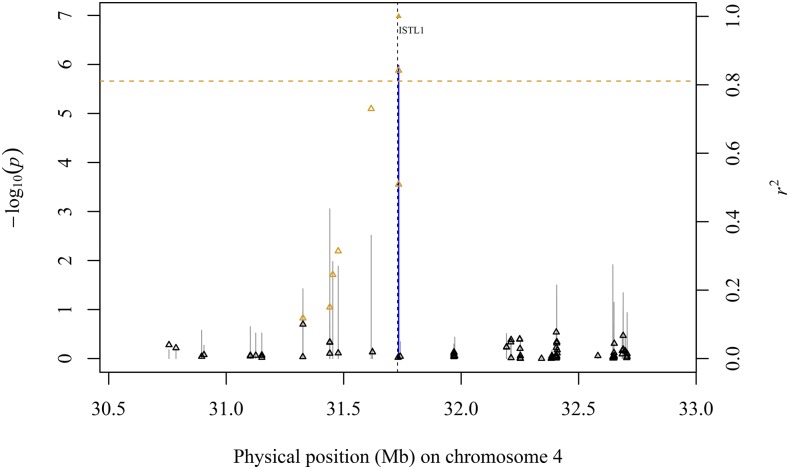
Association of SNP markers with adult maize leaf cuticular conductance (gc) across a genomic region on chromosome 4. Scatter plot of association results from a mixed linear model analysis of gc conducted across all four environments (AllEnv) and linkage disequilibrium (LD) estimates (r2) for a genomic region that contains a gene encoding an INCREASED SALT TOLERANCE1-LIKE1 (ISTL1) protein (Zm00001d049479). The -log10
P-values of tested single-nucleotide polymorphisms (SNPs) are represented by vertical lines. Blue vertical lines are SNPs that are statistically significant at a false discovery rate (FDR) of 10%. The r2 values of each SNP relative to the peak SNP (indicated by a solid orange triangle) at 31,733,973 bp (B73 RefGen_v4) are indicated by triangles. Open orange triangles represent SNPs with r2 > 0.1 relative to the peak SNP. The least significant SNP at a genome-wide FDR of 10% is indicated by a dashed horizontal orange line. The black dashed vertical line indicates the genomic position of the ISTL1 protein.